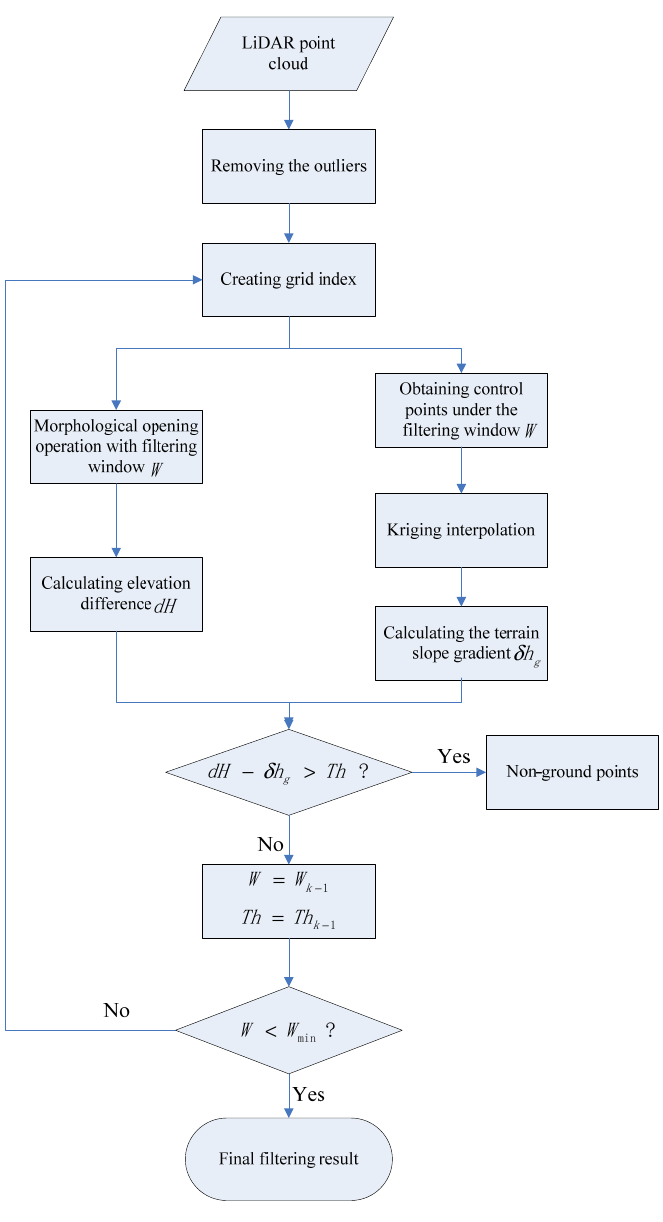
Figure 3. Flow chart of the proposed method.